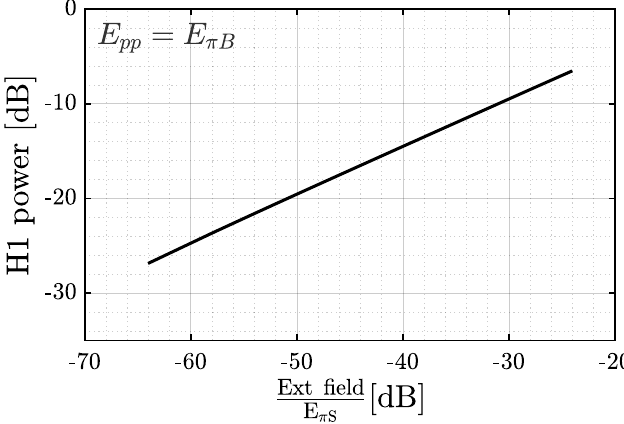
Figure 8. H1 power as a function of the incident electric field.